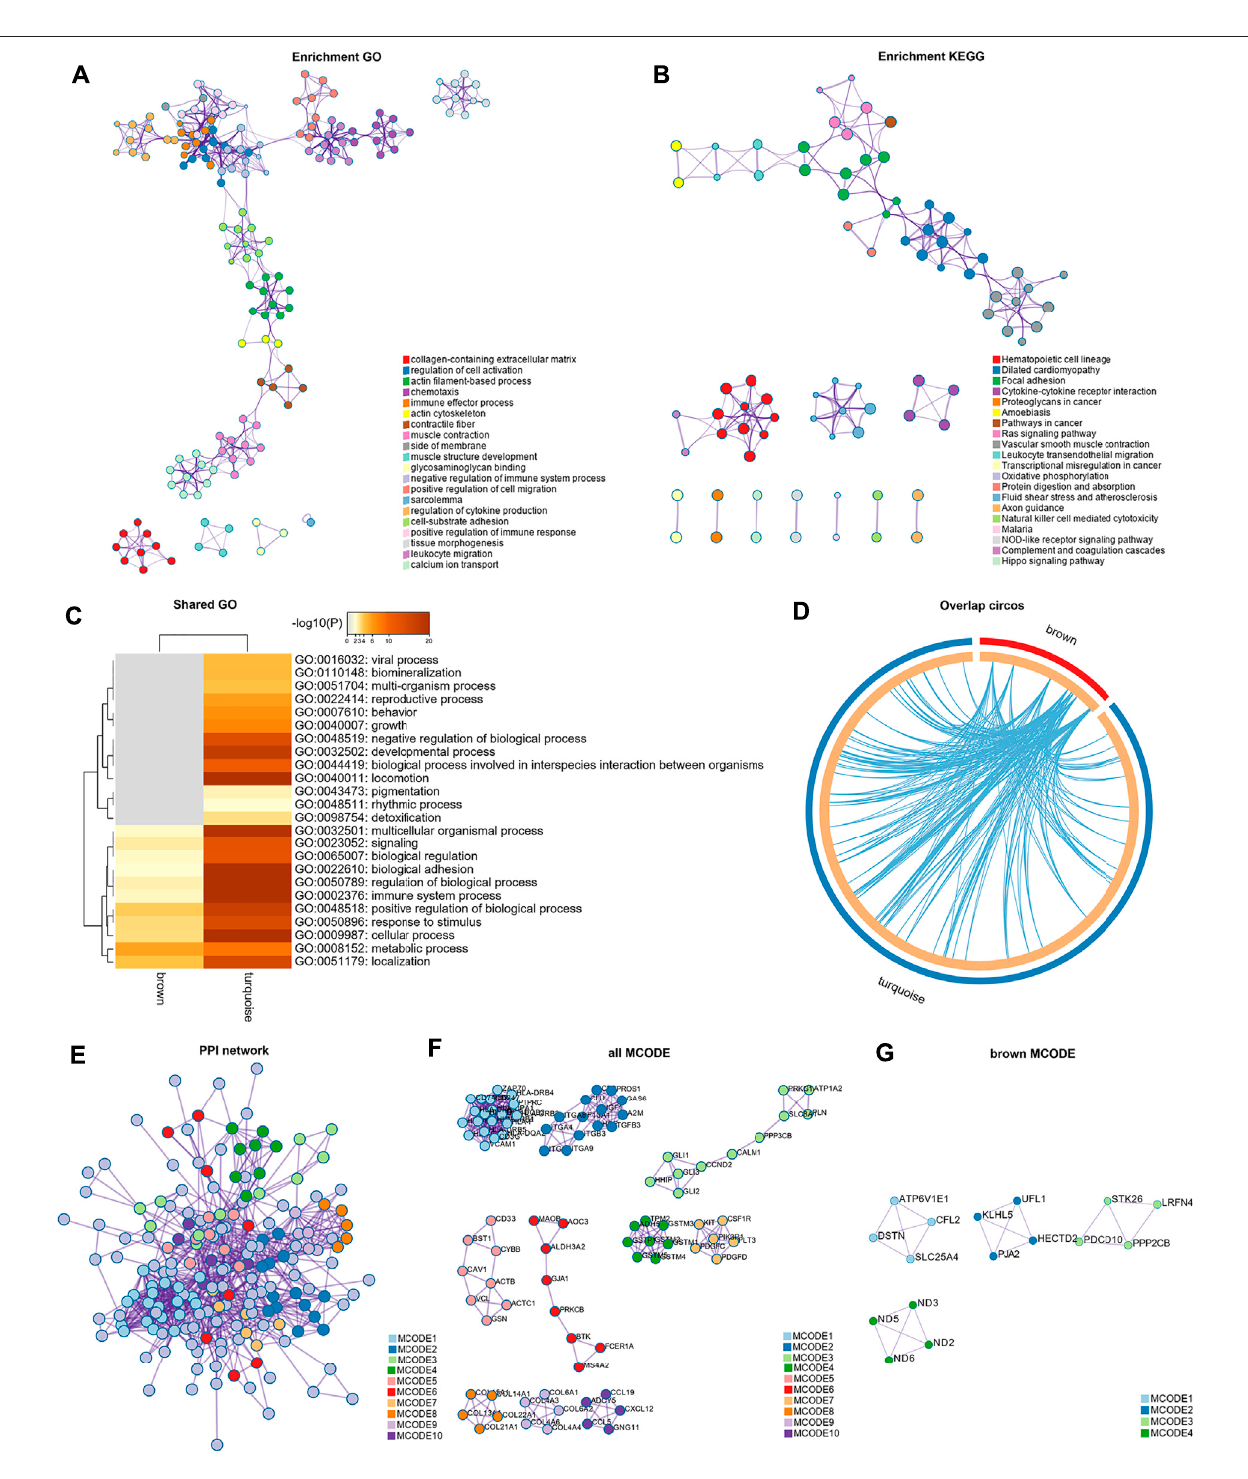
FIGURE6| FunctionalenrichmentanalysisandconstructionofPPInetworkinthebrownand turquoise modules. (A) GOtermsofCRPC-relatedgenes. (B) KEGG pathways of CRPC-related genes. (C) GO terms shared by both brown and turquoise modules. (D) Genes in different modules shared by the same GO terms. (E) PPI network of all proteins in the brown and turquoise modules. (F) Functional modules in the whole PPI network. (G) Functional modules in the brown modules.